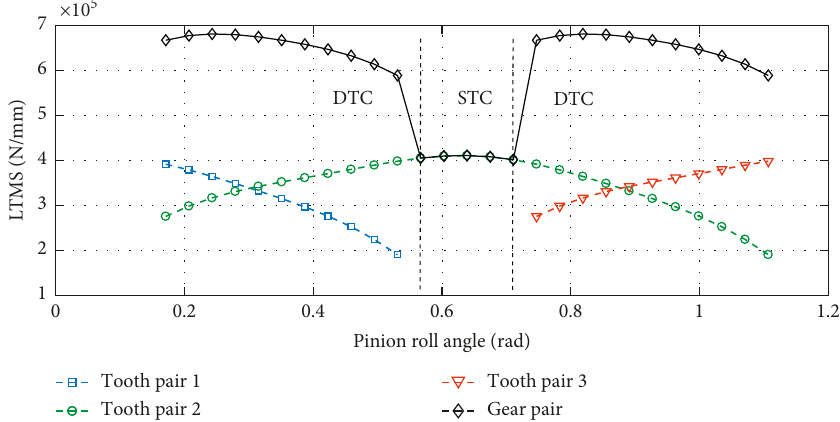
Figure 13: The LTMS of the gear pair and the tooth pair over one tooth engagement cycle at 300Nm applied